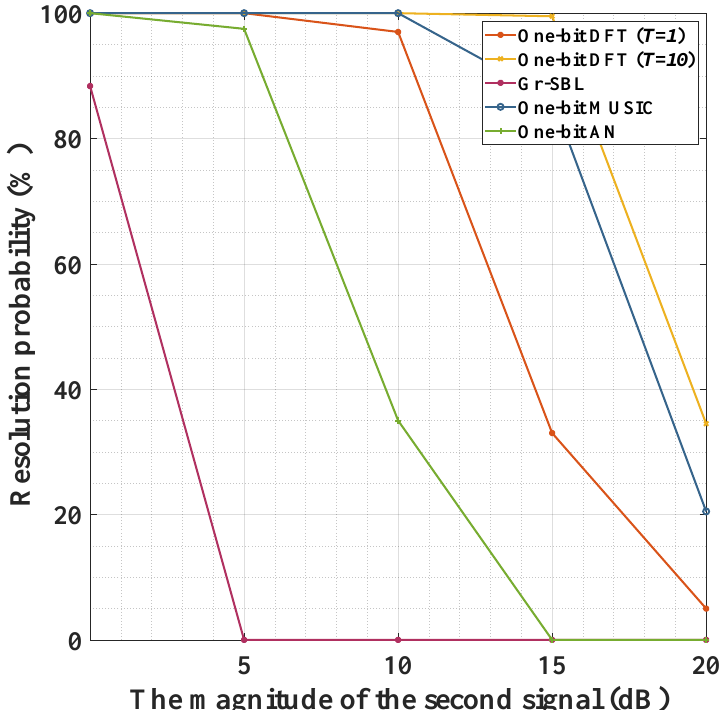
Figure 8. The variation curve of resolution with varying signal magnitude differences among all methods, where SNR =